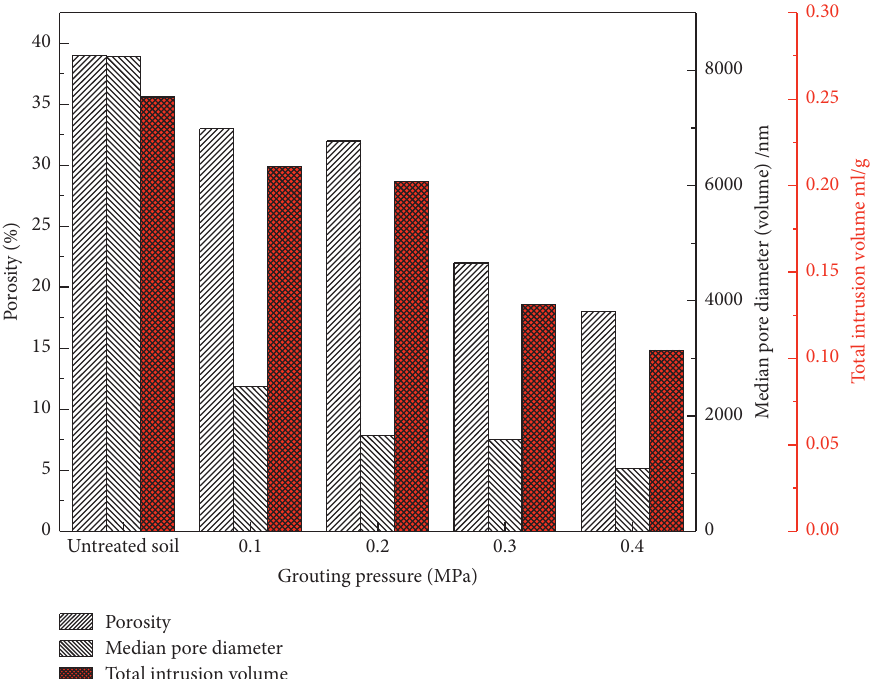
Figure 14: Influence of grouting on characteristic values of pore